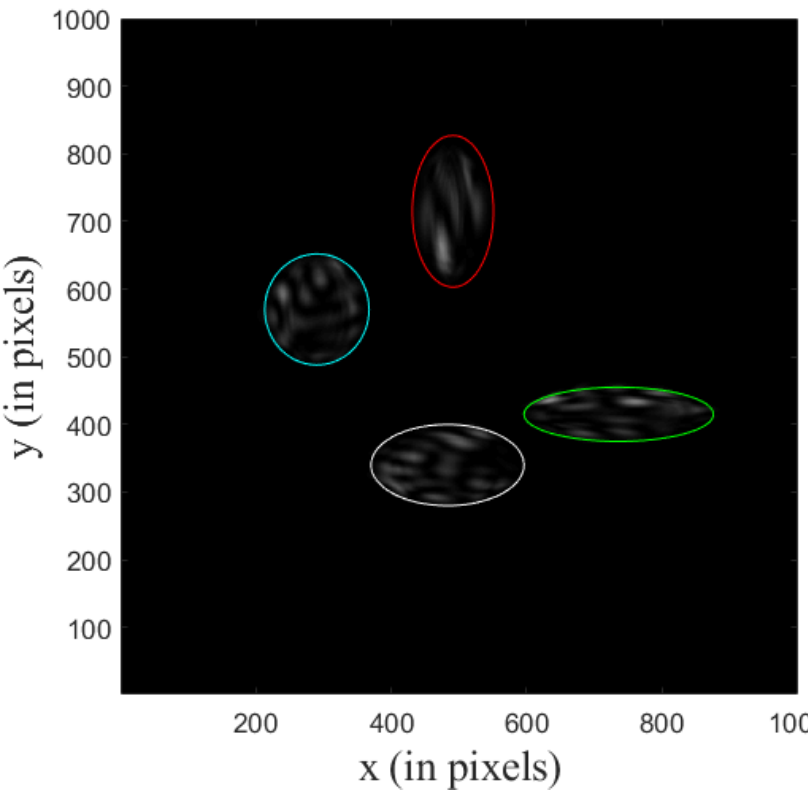
Figure 14. Interferometric pattern simulated with the interferometric images of particles 1, 2, 3, and 4 of Figure 13, whose positions, sizes, and shapes have been deduced from the whole analysis.